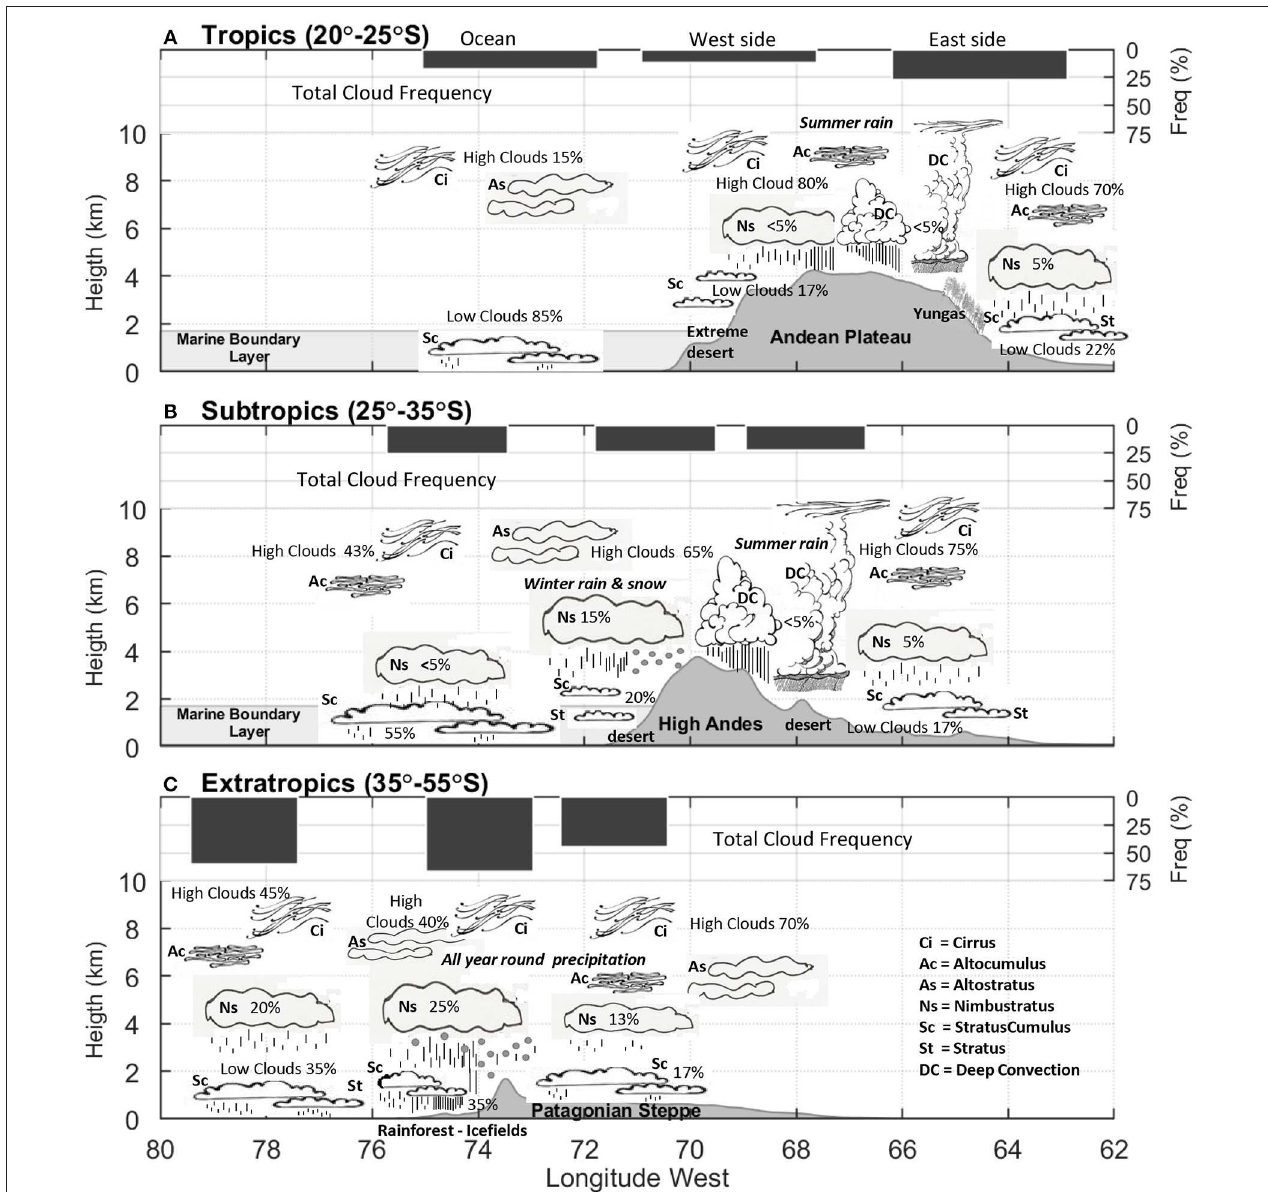
FIGURE 9 | Cross-barrier schematic representation of total cloud frequency (top panels) and relative percentages of cloud types (bottom panels) for (A) the southern Andean plateau (20–25 ◦ S), (B) the subtropics (25–35 ◦ S), and (C) the extratropics (south of 35 ◦ S). Percentages of clouds represent approximately mean values in three main cross-barrier zones [ocean, east side (upstream and upslope), and west side (downslope and lee) of the Andes] estimated from Figures 5 , 7 , which in turn, were obtained from the CloudSat satellite during the 2006–2016 period. The principal cloud types are inferred by the 2B-CLASSCLOUD algorithm of CloudSat.